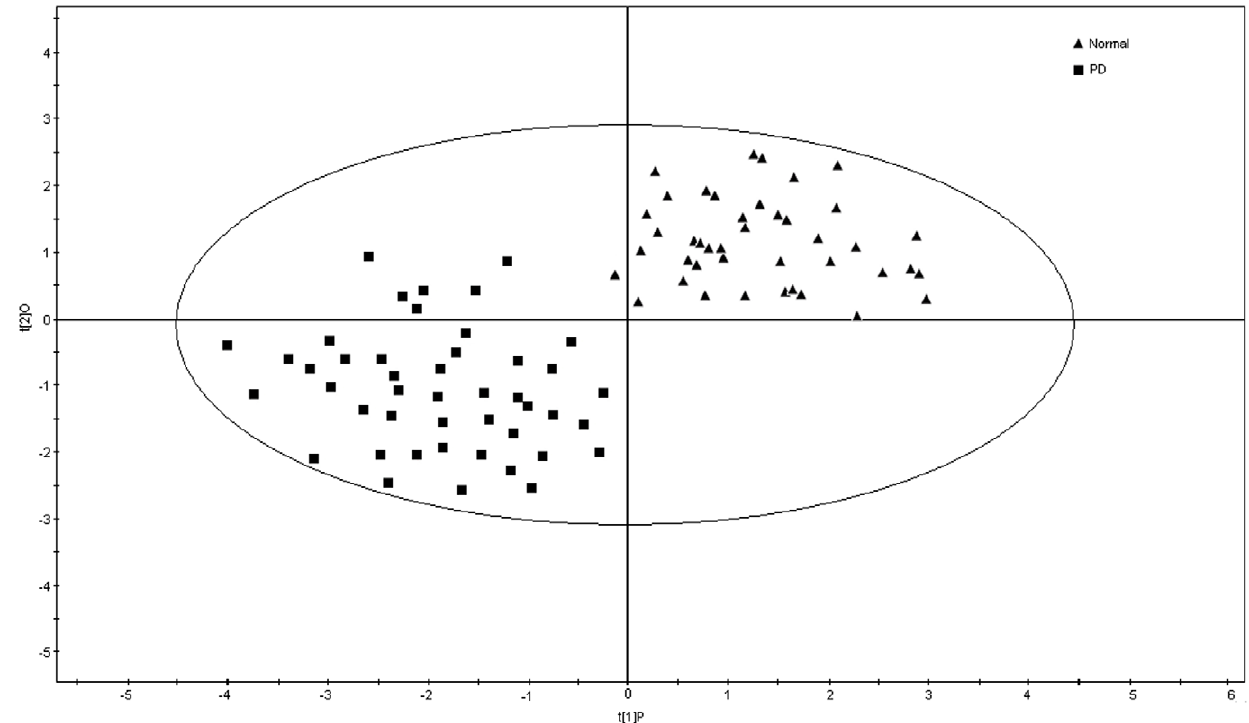
Figure 1. PLS-DA analysis of normal and PD serum elements. PLS-DA score’s plot displays a significant separation between control subjects (n=42) and unmedicated PD patients (n=45) using complete digital maps. The observations coded according to class membership: triangle is normal and rhombus is PD. Each data point on a plot represents one individual.